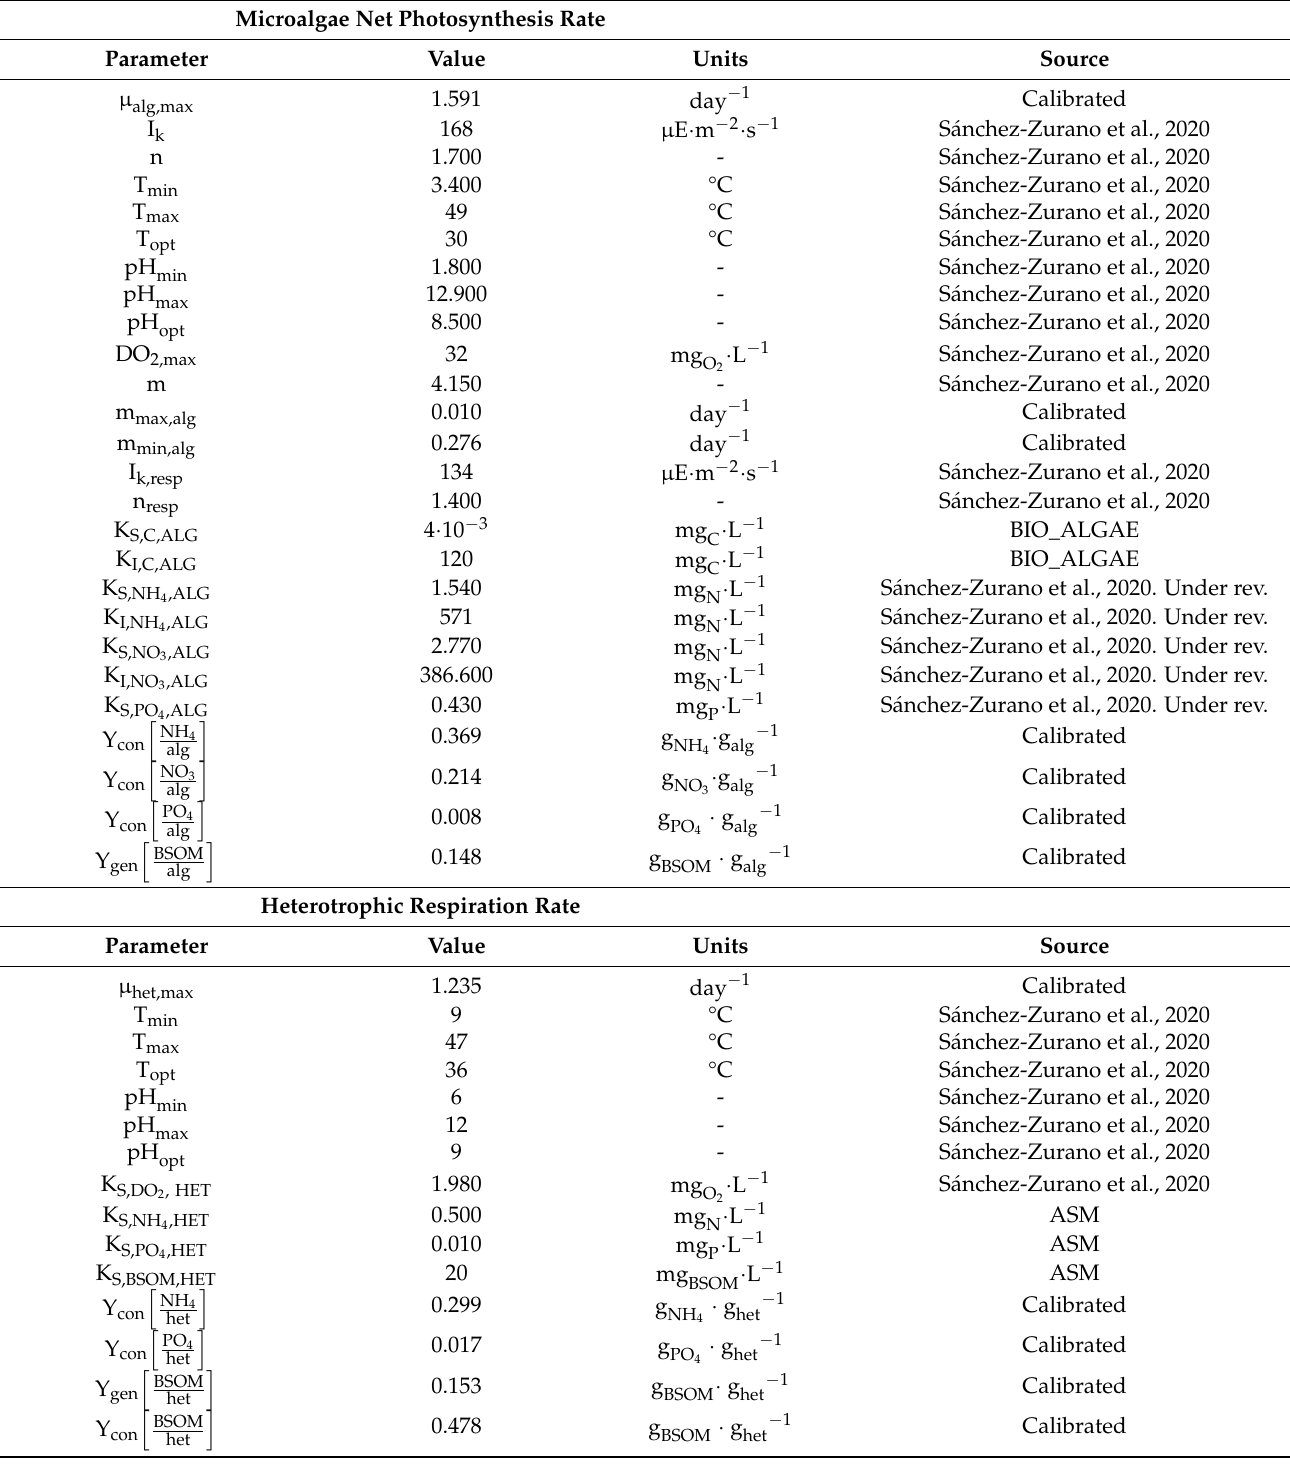
Table A2. Values for the proposed ABACO model’s characteristic